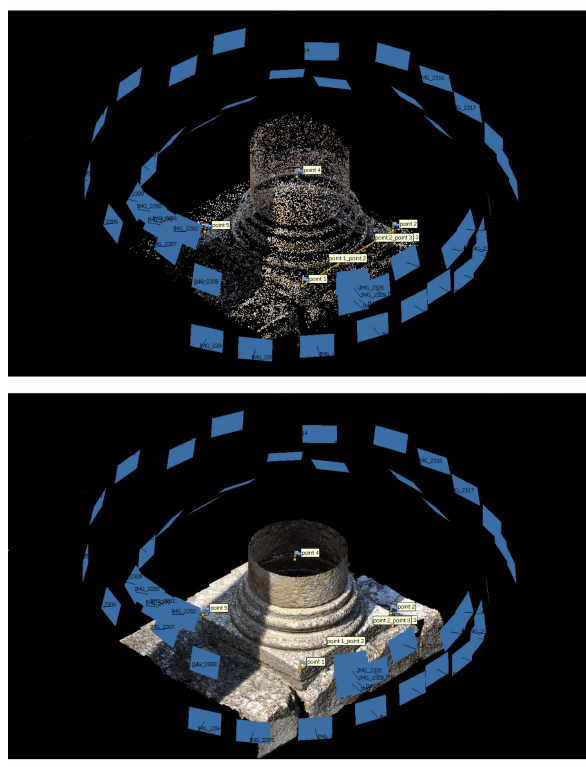
Figure 5. Photomodeling of the plinth and of the Attic base of the column: the alignment process in the point clouds and in the mesh model .